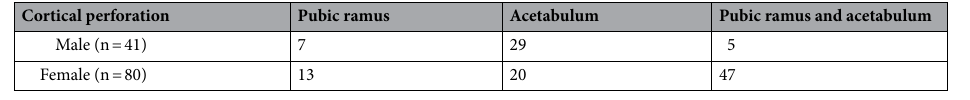
Table 2. Excluded samples with undesired cortical perforation, group 1 (pubic ramus), group 2 (acetabular joint surface) and group 3 (pubic ramus and acetabular joint surface) in relation to sexes.